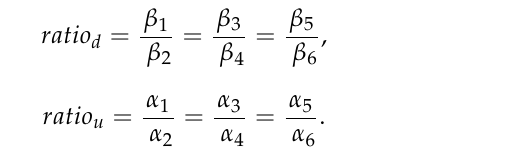
Figure 30. Error histogram between the target values and the estimated values for 𝑞 6 .